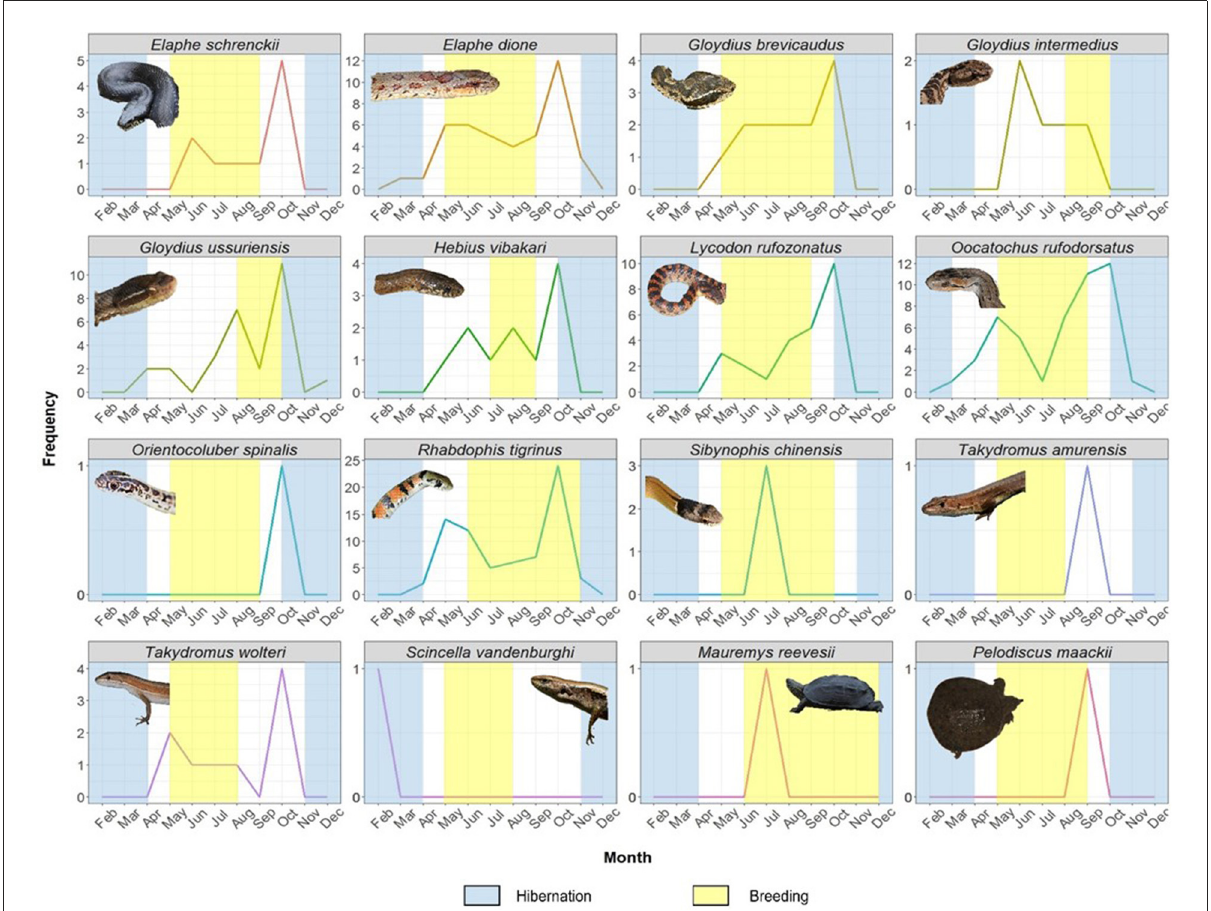
FIGURE6 The monthly roadkill trends for Korean reptiles based on iNaturalist observations ( n 2005 to 13 August 2021 through the iNaturalist project “Herpetofauna Roadkill in the Republic of Korea”. We excluded observations with ambiguous identifications above the species level. The information on breeding and hibernation periods are primarily derived from Lee et al. (2012). The breeding season of Sibynophis chinensis was inferred from Koo et al. (2018) and Banjade et al. (2020), whereas information on the breeding season of Gloydius intermedius was further supplemented from Do et al. (2017). Photographs of reptiles courtesy of Hyun-Tae Kim, modified and used under